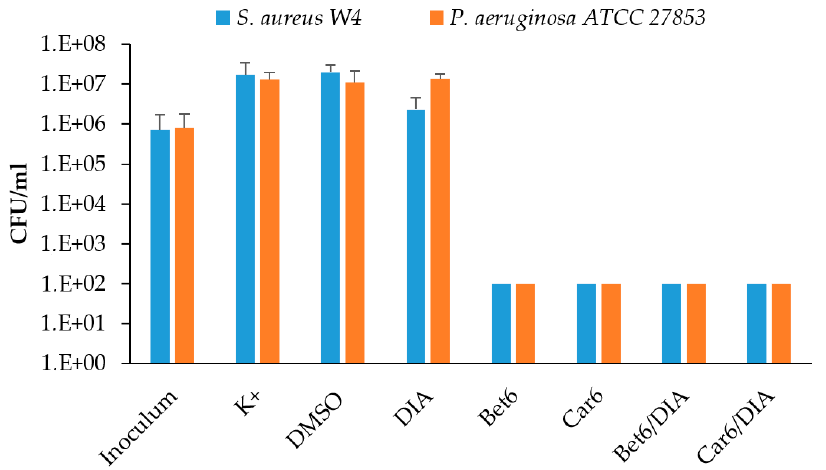
Figure 7. The antibacterial activity of the formulated eye drops based on DIA and ILs (Bet6/DIA and Car6/DIA) was tested against S. aureus W4 and P. aeruginosa ATCC 27853 after 3 h of incubation in 5% TSB. Unmedicated IL solutions (Bet6 and Car6) and a plain DIA suspension were also tested. K+ represents bacteria incubated in medium only. DMSO represents bacteria incubated in medium with the addition of 0.6% DMSO. The concentration of DIA used alone and with the ILs was 0.34 M, and the ILs were tested at 0.27 M. Bactericidal activity was defined as a reduction in the numbers of viable bacteria by ≥ 3-log colony-forming units (CFU)/mL after 3 h of incubation. Data are reported as the mean ± SEM of two independent experiments.